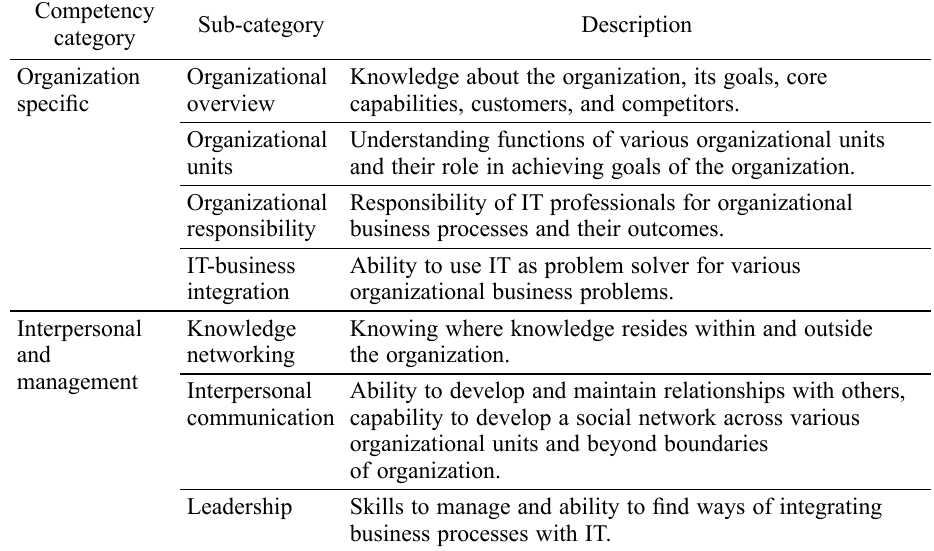
Table 1. Business competency categories of IT professionals (Adapted from Bassellier and Benbasat